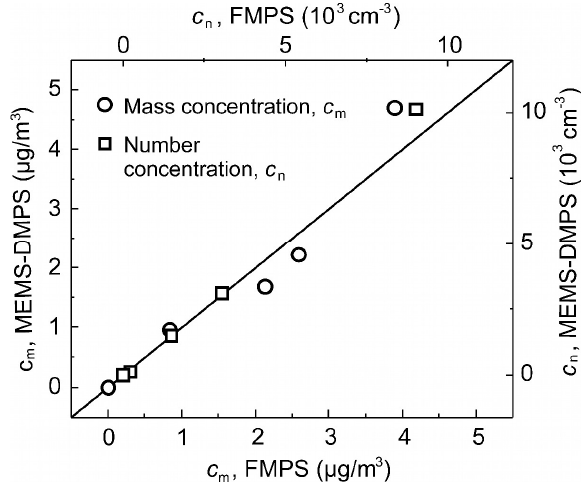
Figure 8. Correlation plot of mass concentration c m and number concentration c n of a